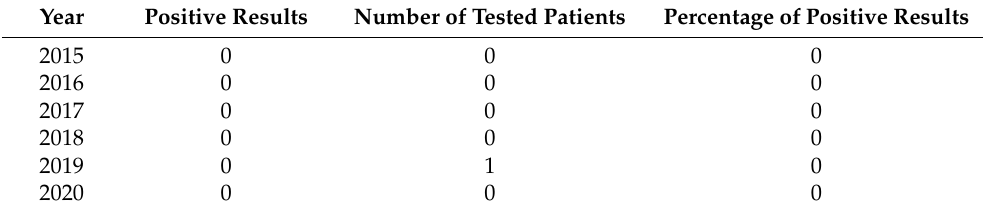
Table 14. Anti-Aspergillus antibodies (IgG) in NICU patients.